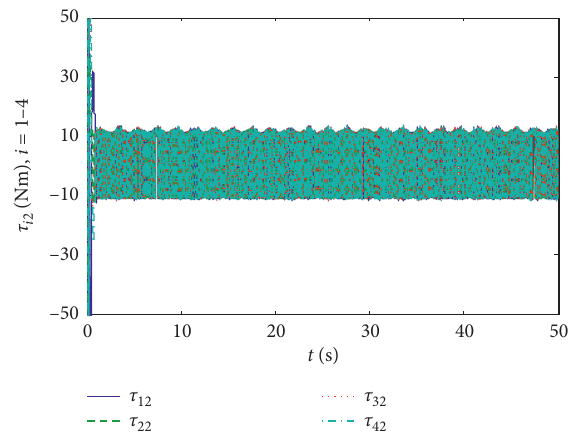
Figure 14: The control input torque τ